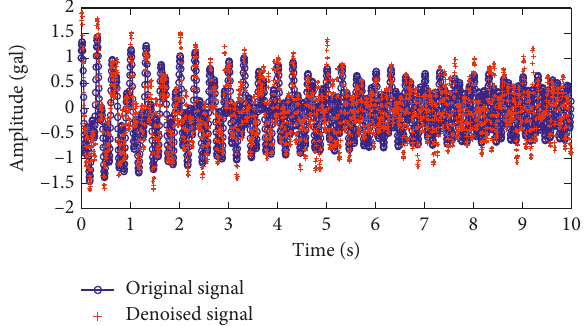
Figure 4: Comparison figure of original signal and denoised signal using EEMD.